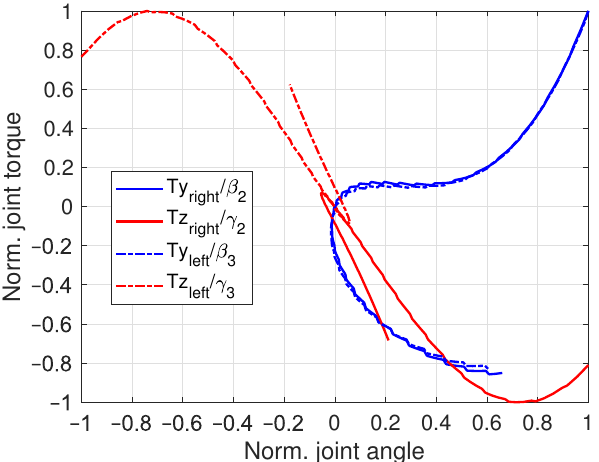
Figure 12. Normalized elbow joint torques over normalized joint angle.